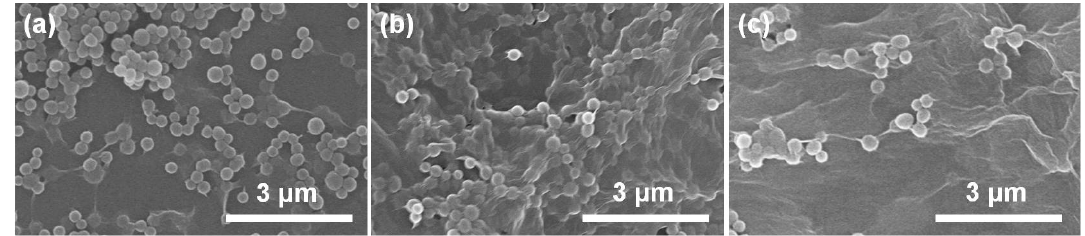
Figure 2. SEM images of PPy/rGO-S1 ( a ), PPy/rGO-S2 ( b ), and PPy/rGO-S3 ( c ).